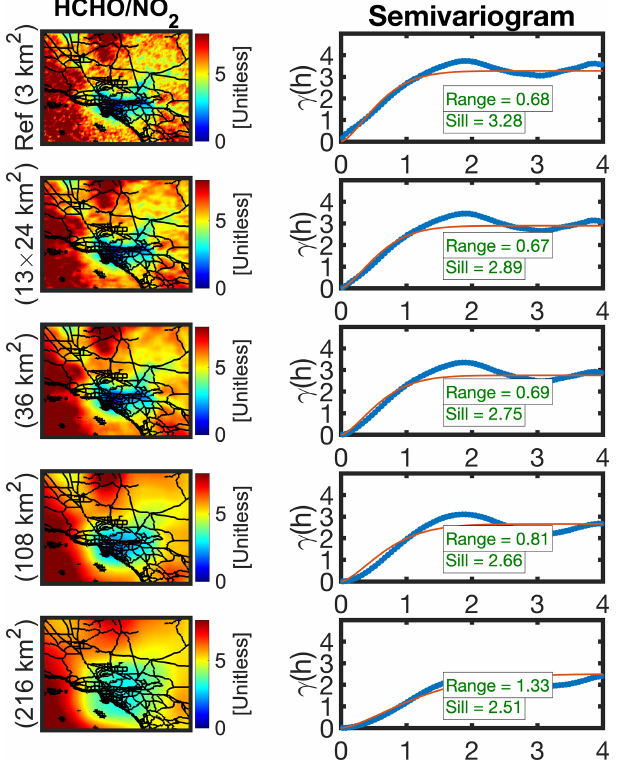
Figure 8. The first column represents the spatial map of HCHO / NO 2 ratios over Los Angeles from June till August 2021 at different spatial resolutions. To upscale each map to a coarser footprint, we use an ideal box filter tailored to the target resolution. The second column shows the semivariograms corresponding to the left map along with the fitted curve (red line). The sill and the range are computed based on the fitted curve. The x axis in the semivari- ogram is in degrees (1 ◦ ∼ 110km).